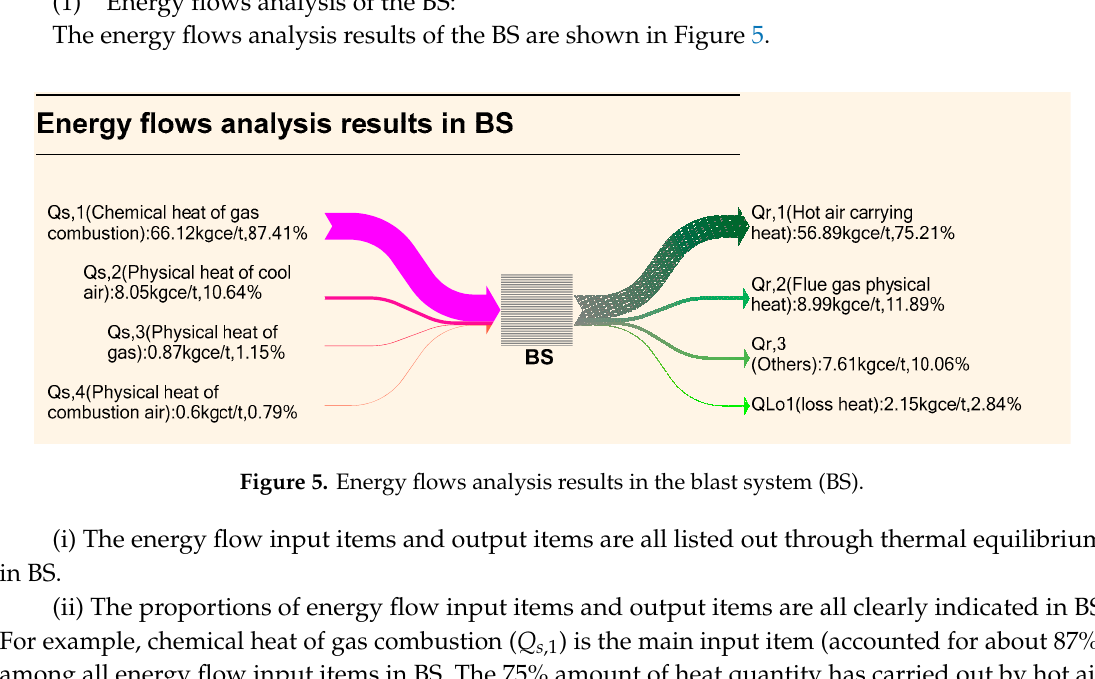
Figure 5. Energy flows analysis results in the blast system (BS).